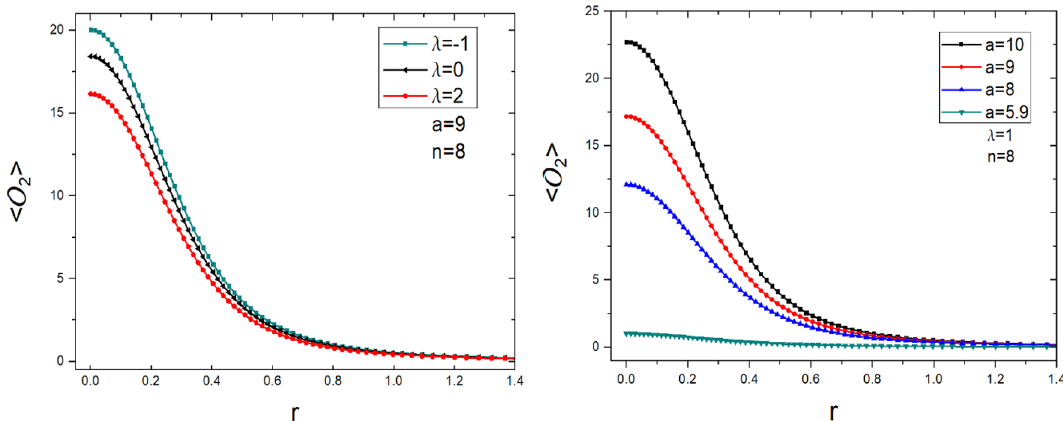
Figure 2 . Left : hO 2 i against r , for several λ = − 1 , 0 , 2 . The black solid line is the non-self- interacting result for reference. Right : hO 2 i against r . From top to bottom, we have a = 10 , 9 , 8 , 5 . 9 . For both panels we take n = 8 and q = 2 . 15 .